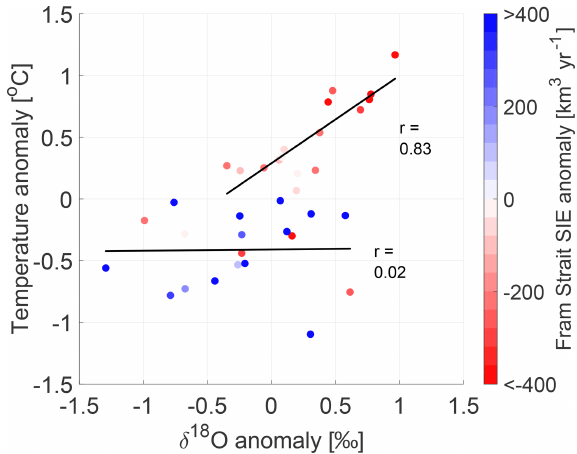
Figure 11. Annual temperature anomaly plotted with respect to an- nual δ 18 O anomaly, where colors indicate the strength of the Fram Strait sea ice export anomaly. A 5-year moving average has been ap- plied to all the time series but only every 5 points are displayed and used in the analysis. The solid black lines represents linear fits be- tween δ 18 O and temperature for positive and negative temperature